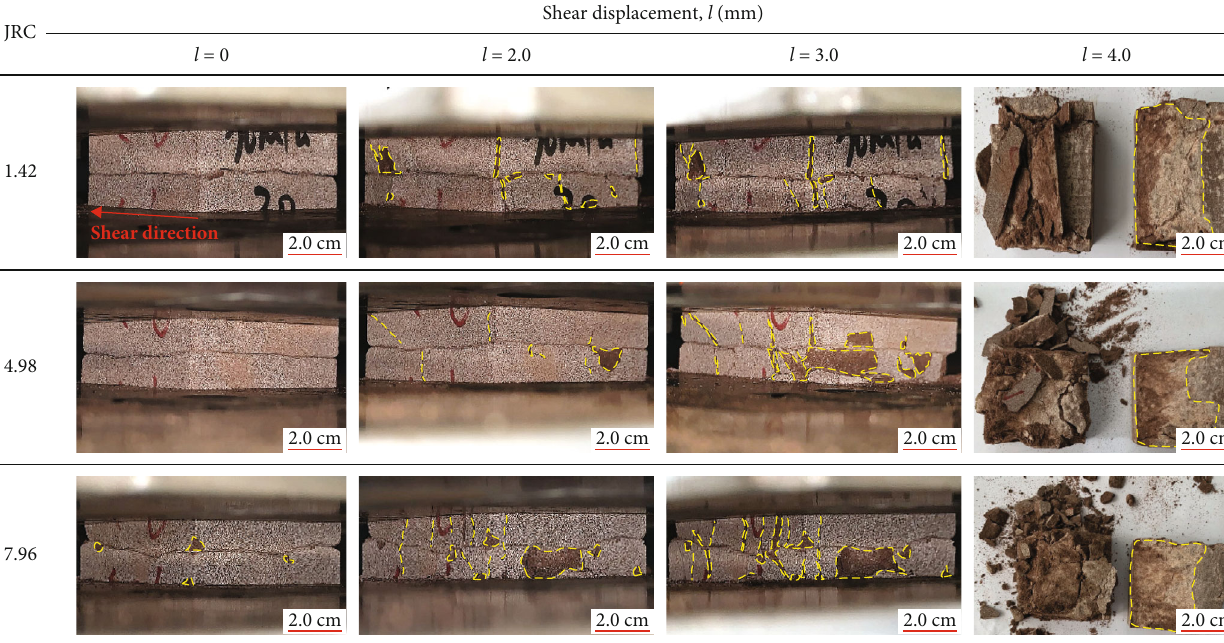
Figure 9: Shear failure process and damage zone of test joint specimens with di ff erent JRC values at normal stress of 30